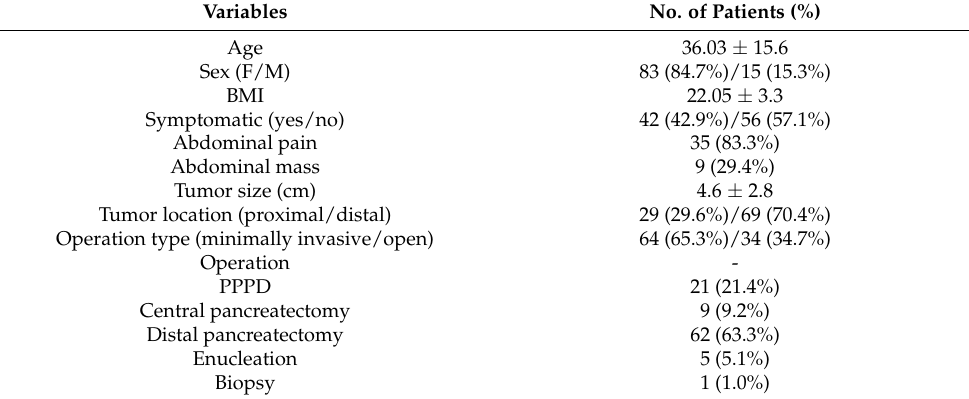
Table 1. General patient data of all 98 patients.